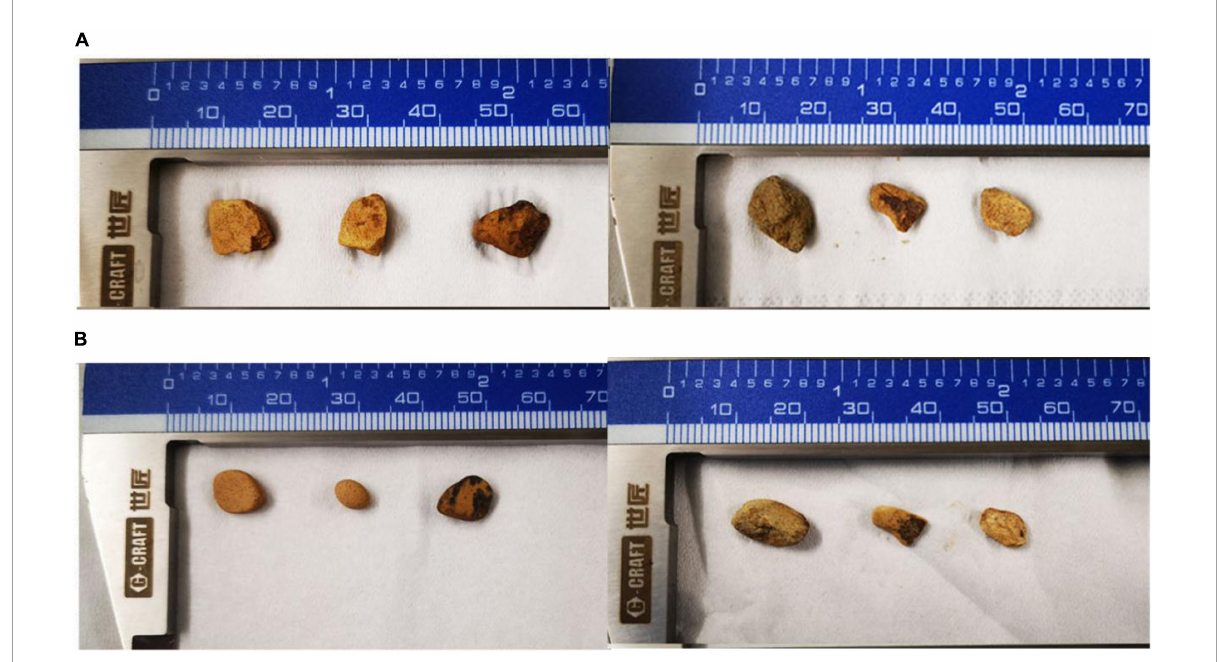
FIGURE3 The dissolution of the rock after 10 days by P. simplicissimum . (A,B) Means three replicates in the X-45 treatment group before and after the experiment,